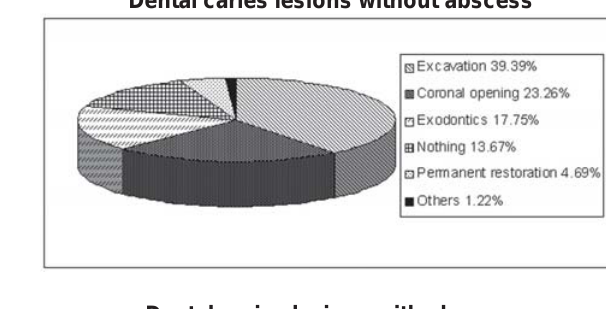
FIGURE 1- Dental caries lesions and trauma percentage in relation to total of complaints in different age groups